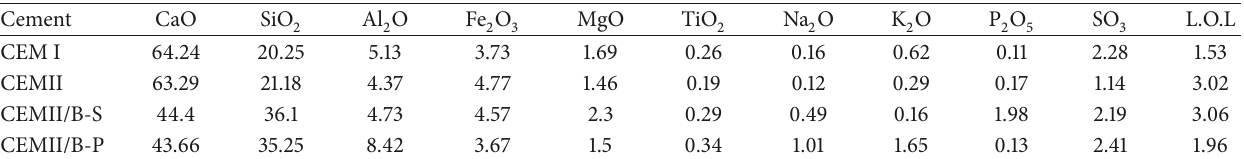
Table 2: Chemical composition of cement used (%) [33].